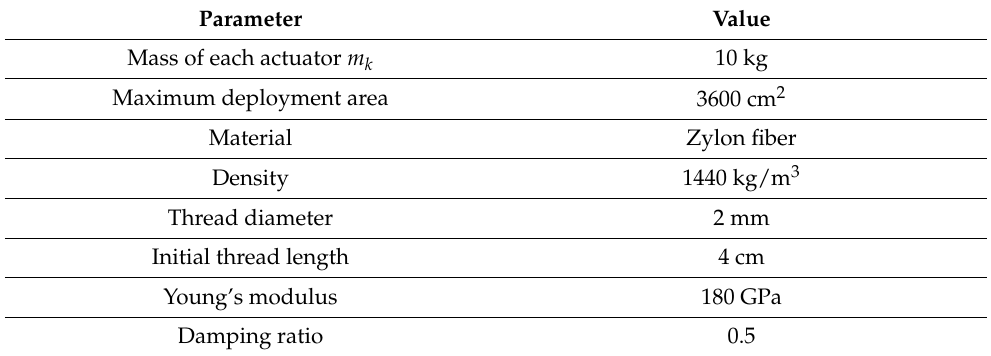
Table 3. Simulation parameters of the flexible